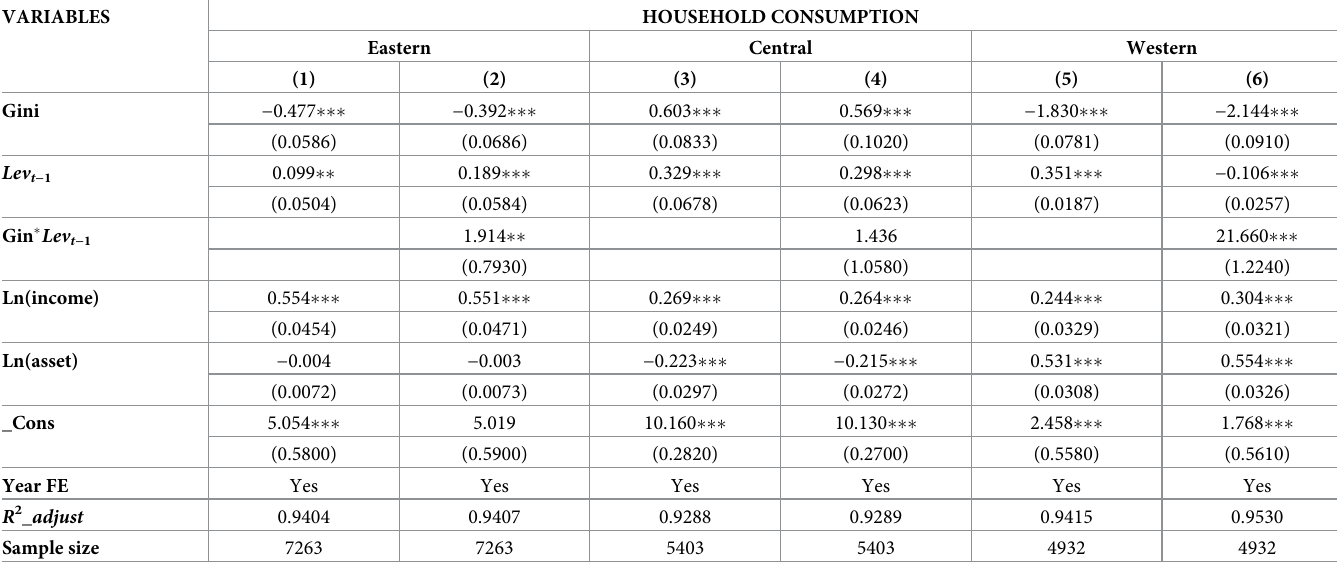
Table 4. Regional differences in the impact of income inequality and household debt on household consumption.